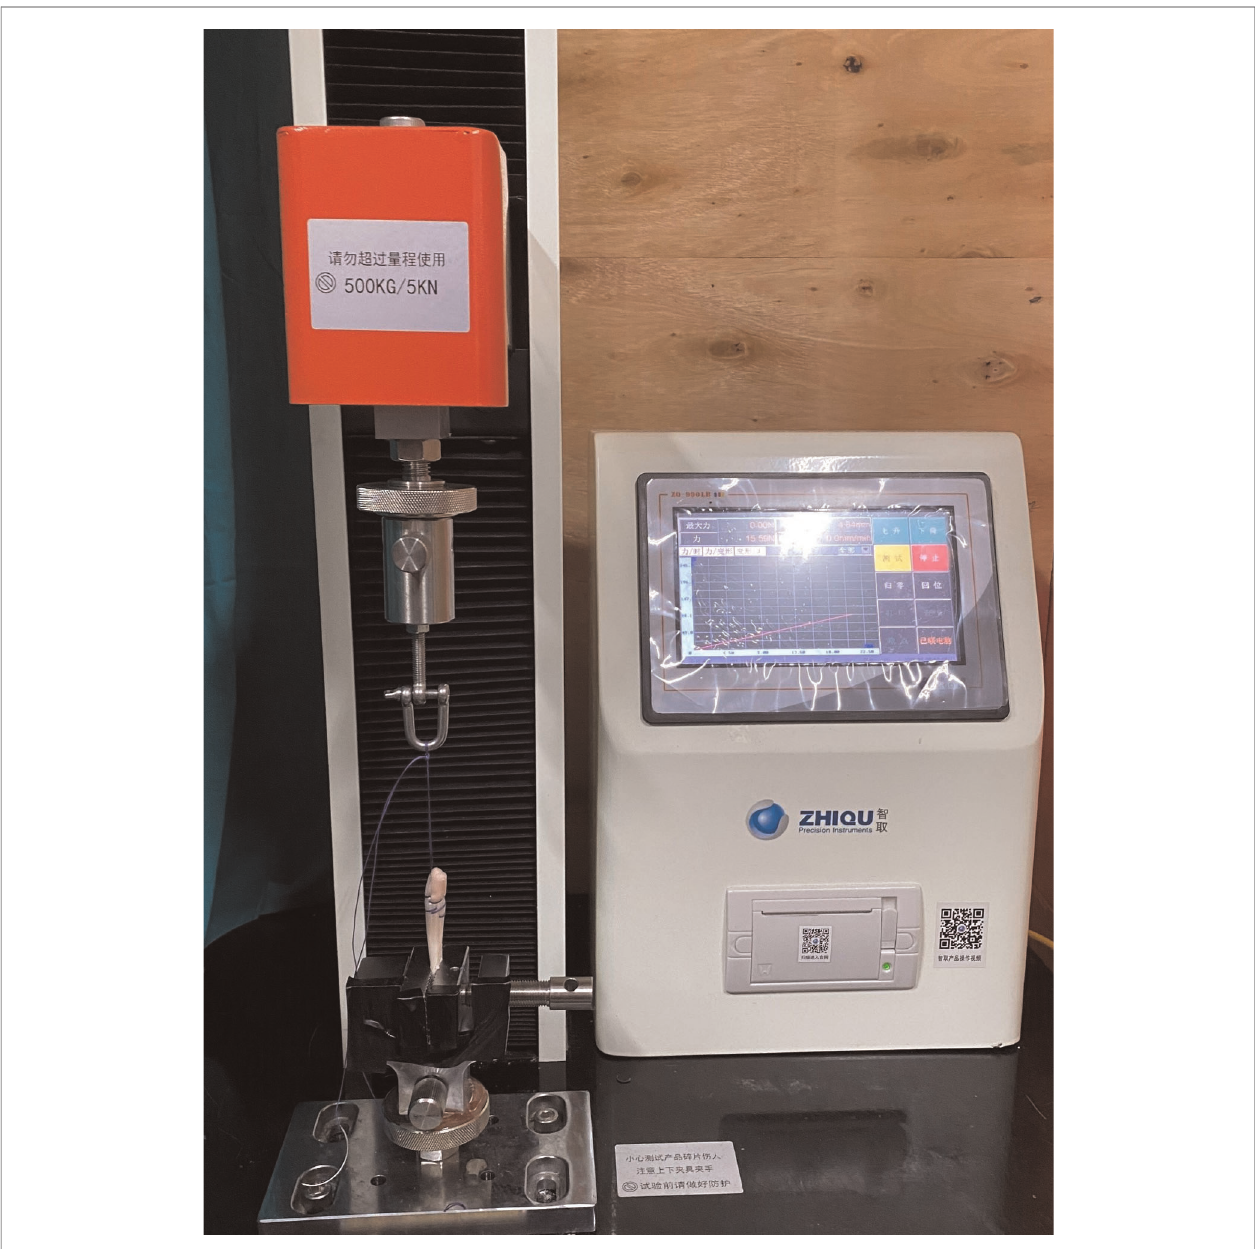
FIGURE 2 | The graft with the needle stitching technique is placed in an electric tensile test system before the pretension